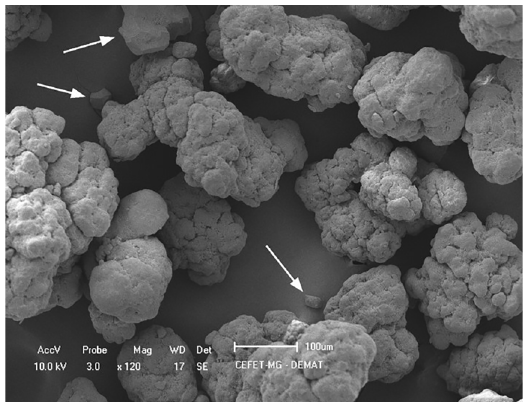
Figure 3. SEM image of the UHMWPE powder filled with 10% of iron ore fine.